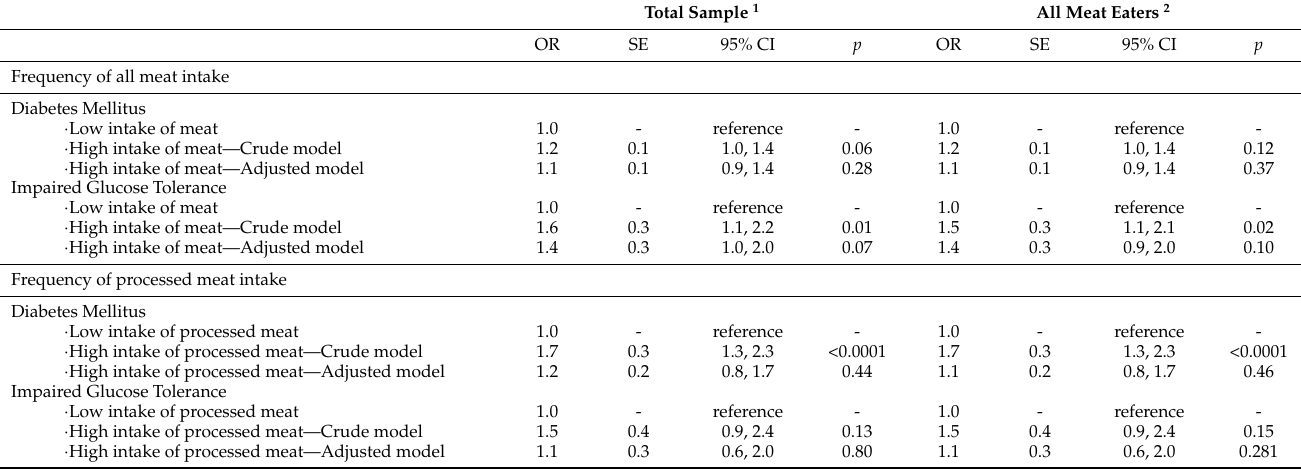
Table 4. Crude and adjusted models of the odds of IGT and DM across meat and processed meat intake for the Total Sample and All Meat Eaters in the ALSWH 1946–51